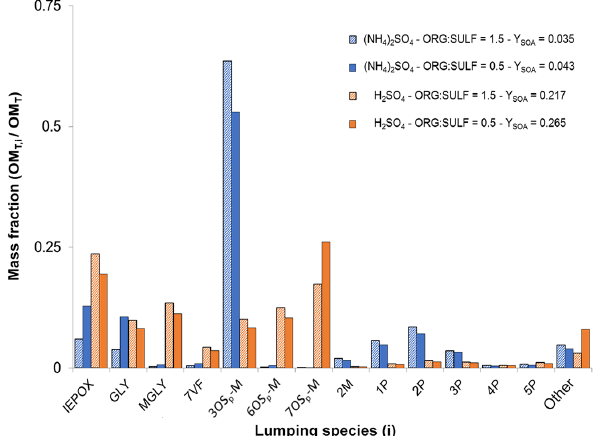
Figure 7. The mass fraction (MF i = OM T ,i / OM T ) of each lump- ing species, i , that contribute significantly to the simulated isoprene SOA in the presence of ammonium sulfate, (NH 4 ) 2 SO 4 , and sulfu- ric acid seeds, H 2 SO 4 , at organic-to-sulfur mass ratios of 0.5 and 1.5. The MF i of the remaining lumping groups are summed and in- cluded in “OTHER”. The MF i , Y SOA and org:sulf are calculated at the point of maximum SOA mass with an initial VOC / NO x ratio of ∼ 17 (experiment SA1 in Table